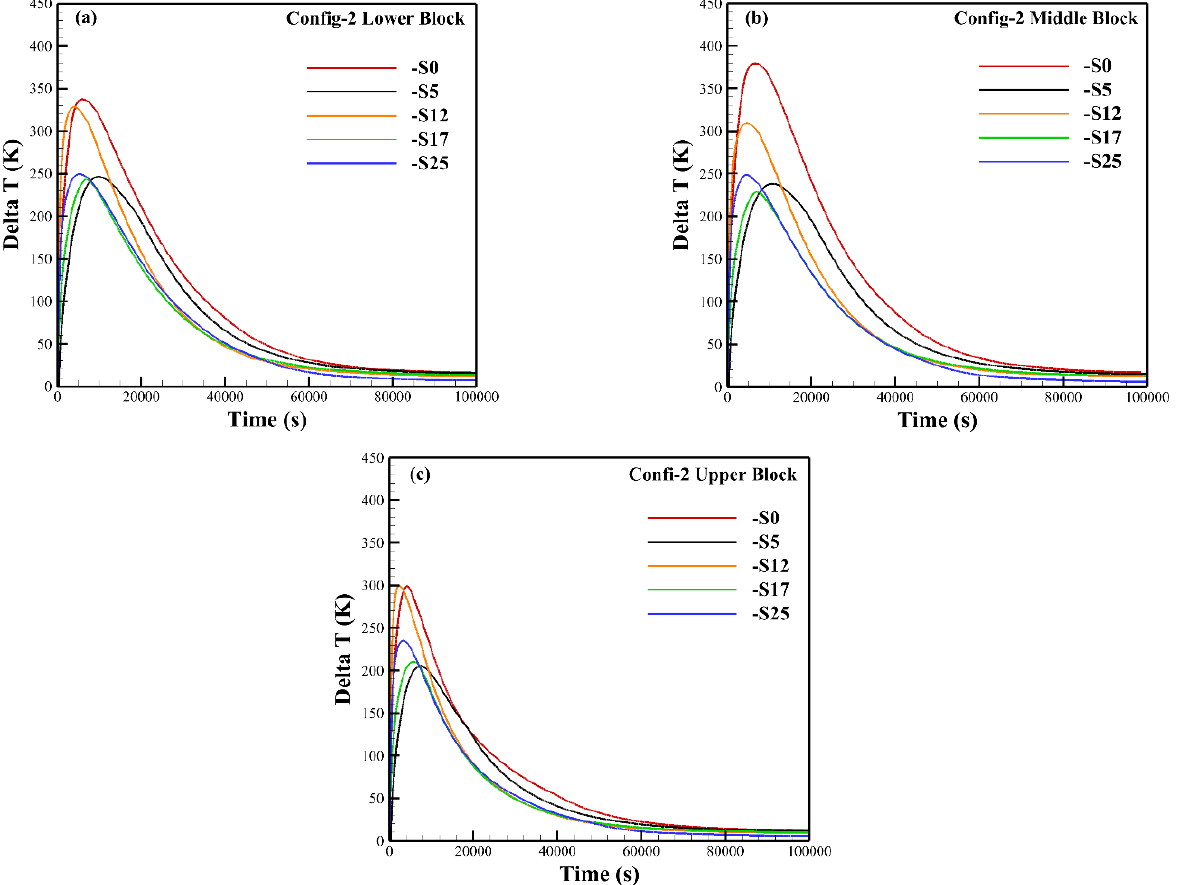
Figure 11. Transient histories of blocks’ temperature non-uniformities in Config-2-S0.